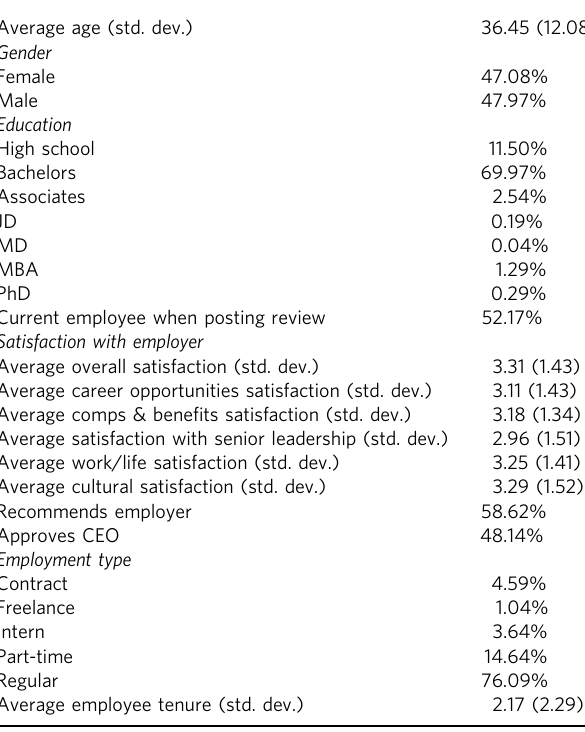
Table 1 Summary statistics for Glassdoor reviewers. Average age (std. dev.)